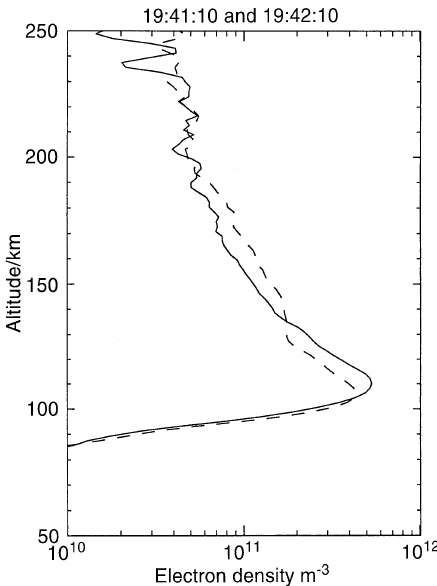
Fig. 8. Electron density profiles (10-s integration) measured by the EISCAT CP-3 programme on 7 December 1994 19:41:10 ( full line ) and 19:42:10 ( broken line ) with 64 ° elevation Table 2. Comparison of data derived from optical observations and from EISCAT measurements Time Peak